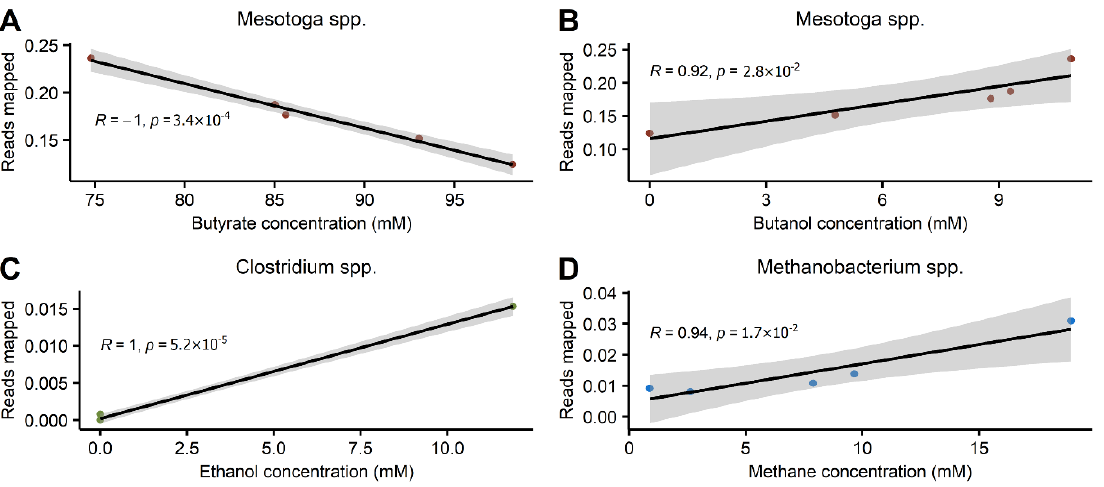
Figure 11. ( A – D ) Comparison of the relative abundance of selected genera to substrate/product con- centration along the bioreactor fermentation. “R” corresponds to the Pearson correlation coefficient and “p” is the p -value of the correlation.